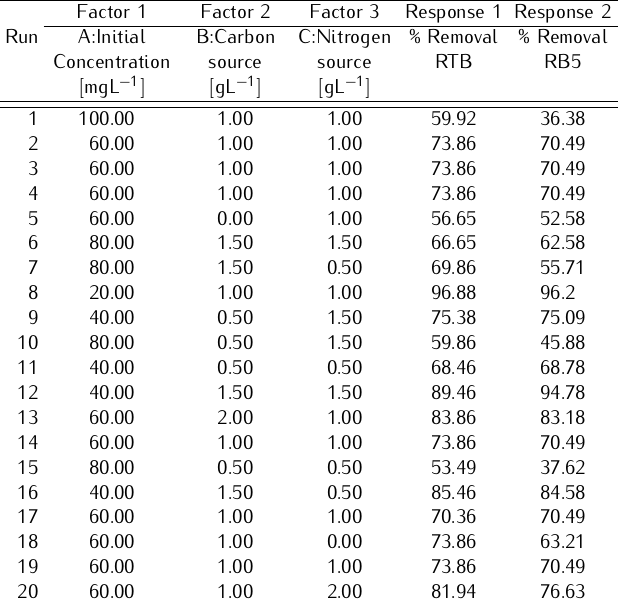
Table 4. Experimental design and results of the Central composite design for the decolourization of RTB and RB5.